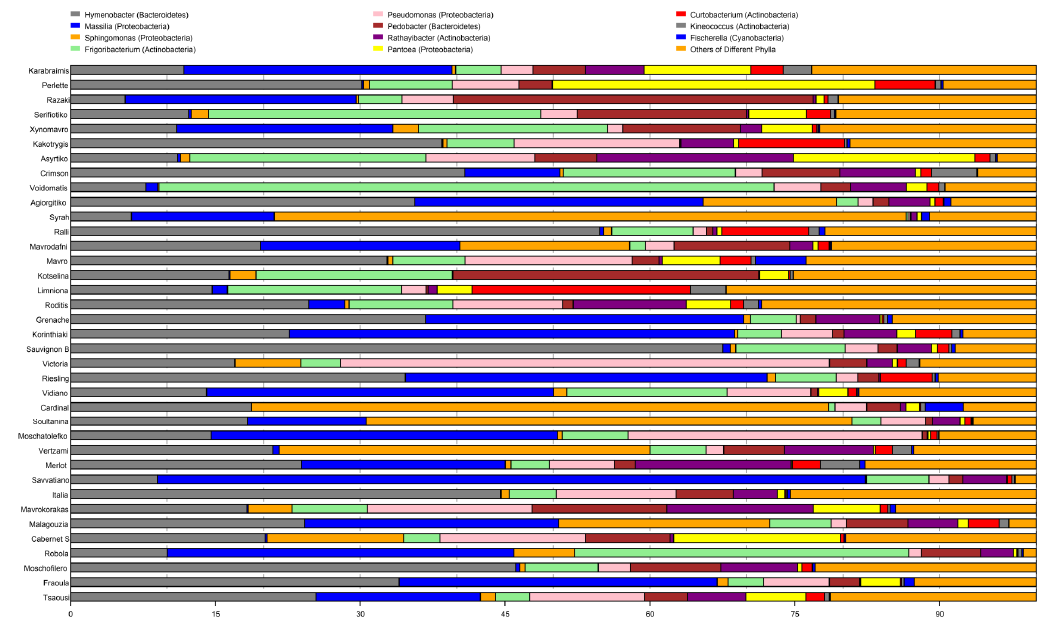
Figure 5. The relative abundance of the top 11 bacterial genera among the 37 Figure 5. Relative abundance of the top 11 bacterial genera among the 37 cultivars 16